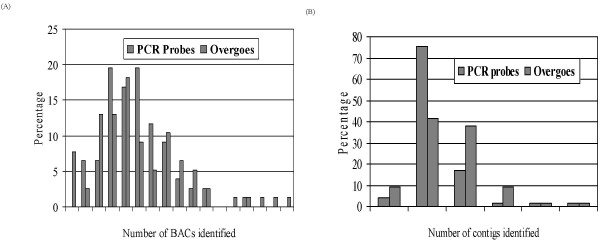
Distribution of BAC, Contig/marker hits. BAC and contig data from both the PCR-based screening on pool and overgo hybridizations are illustrated for the distribution of BAC hits/marker (A) and contig hits/marker (B) for 81 markers.